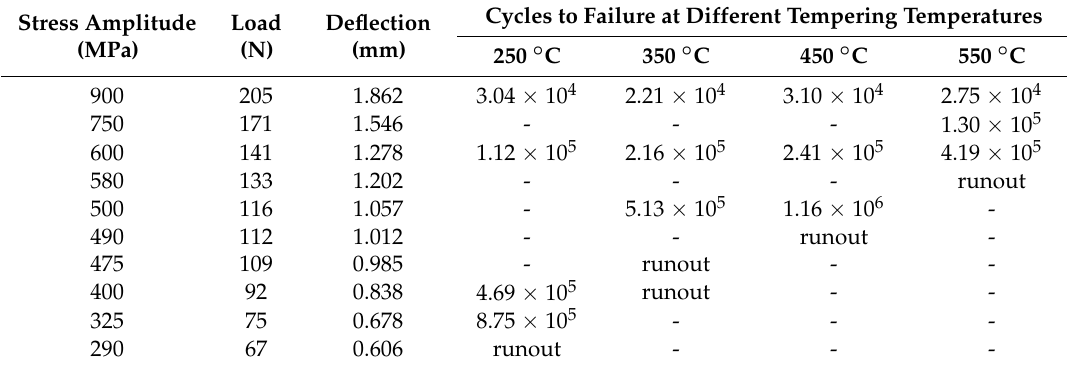
Table 2. Fatigue life measured at various stress levels with different tempering temperatures.